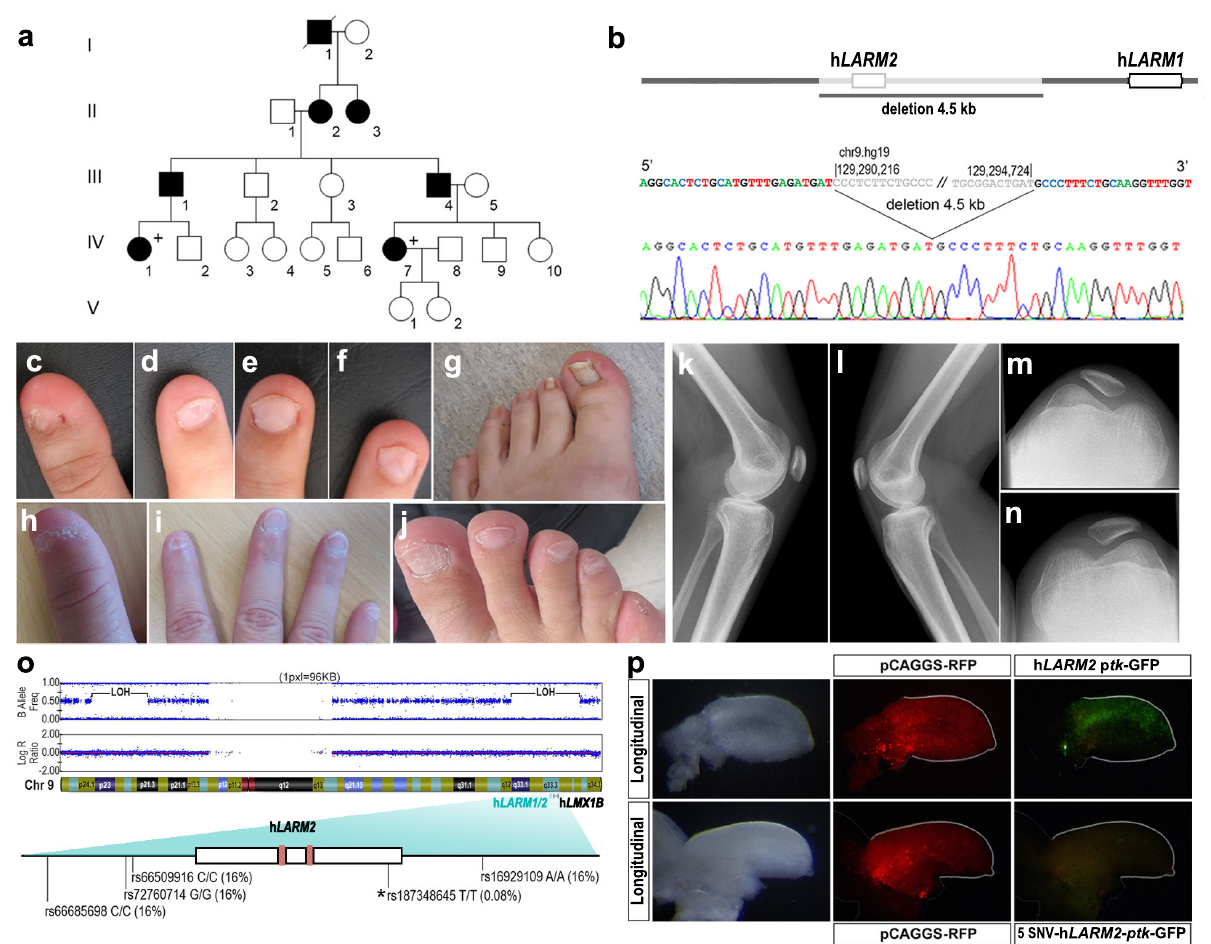
Fig. 5 Clinical features of LARM loss-of-function. a Pedigree of a family with a LARM deletion. b The 4.5 kb region deleted removes all of LARM2 . c – g , k – n Phenotypic images of individual IV-7. c – d Koïlonychia of thumb and 2nd fi nger. e – f Triangular lunulae of 3rd and 4th fi ngers. g Nail dysplasia of the hallux showing longitudinal striations. h – j Phenotypic images of individual IV-1. h Koïlonychia of thumb. i Hypoplastic nails, ungueal dysplasia of 2nd fi nger. j Ungueal dysplasia of right foot predominating on 1st and 5th toes. k – n Knee X-rays showing bilateral hypoplasia of the patella. o Schematic of the patient ’ s chromosome 9 showing large segments of the chromosome with loss of heterozygosity (LOH), i.e., homozygosity, when comparing the allele